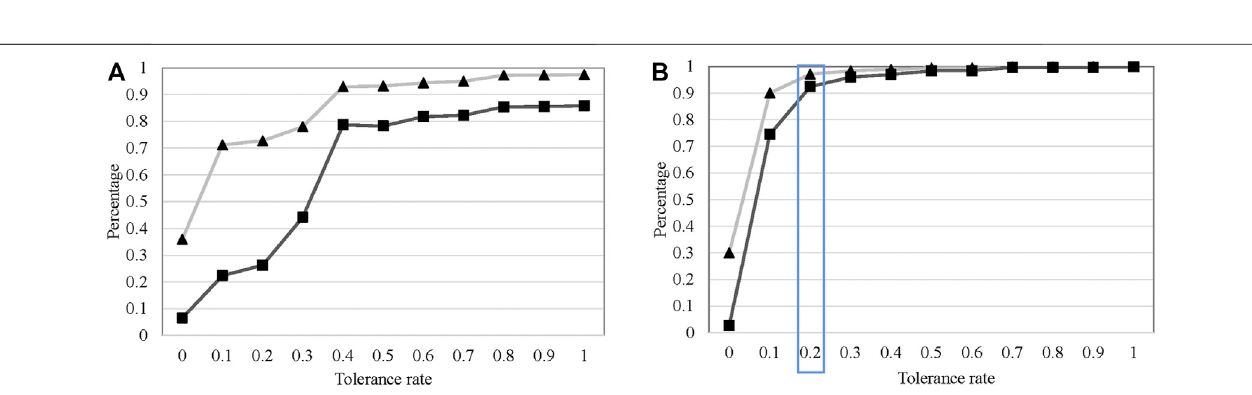
FIGURE 4 | Cascading failure in the electric network in Texas, triggered by the removal of a single node chosen among those with (A) the highest load and (B) at random (remove one node randomly and repeat as many times as the number of 1% of total nodes). The curve shows changes in the size of the largest connected components ( C l ) ( ■ square) and the number of surviving nodes ( ▲ triangle) in the network.